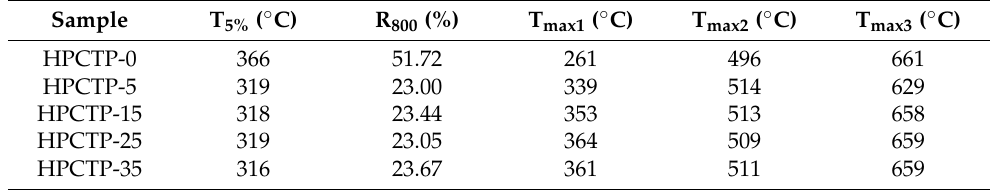
Table 3. Thermal analysis parameters of HPTCP and HPCTP-containing EMVSR composites.